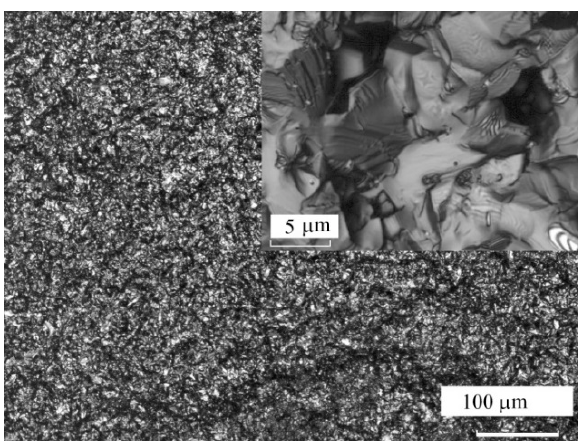
Figure 5. Image fragments of the surface for the mechanical chip of the barium strontium niobate (BSN)-50.